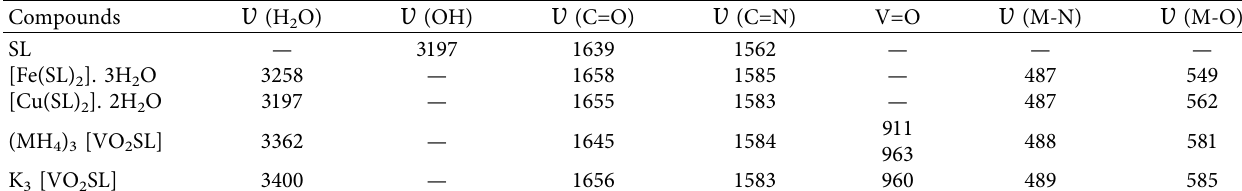
Table 1: Important IR spectroscopic data (cm − 1 ) of the ligands (SL) and their Cu 2+ , Fe 3+ , and V 5+ complexes. Compounds Ʋ (H 2 O) Ʋ